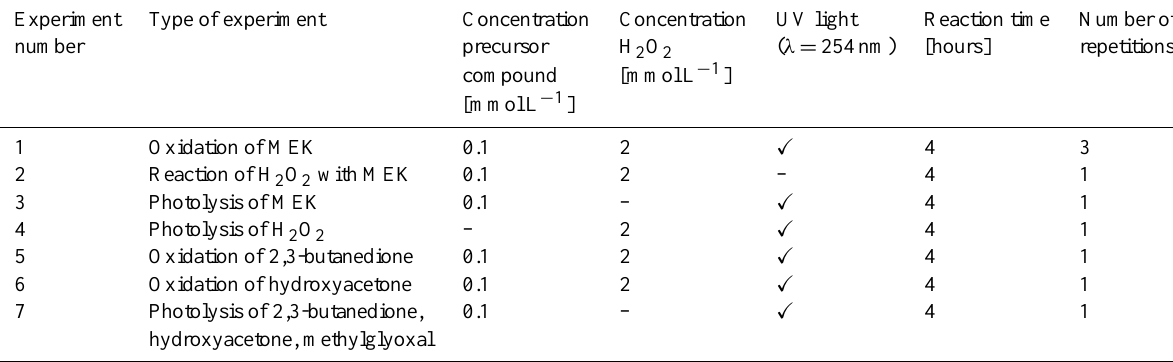
Table 1. Conducted experiments in the bulk reactor. Experiment Type of experiment Concentration Concentration UV light Reaction time Number